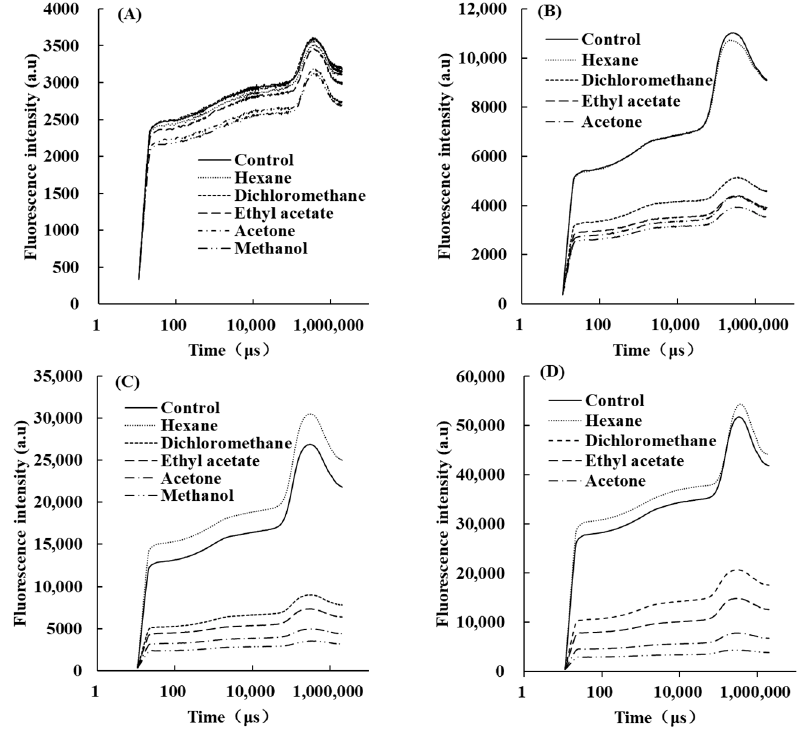
Figure 6. The fast chlorophyll fluorescence curves of M. aeruginosa treated with the eluting fractions of SPE-enriched aqueous extracts from D. indicum flowers at 2.0 g · DW · L − 1 . ( A ) Day 0; ( B ) day 3; ( C ) day 6; ( D ) day 9.